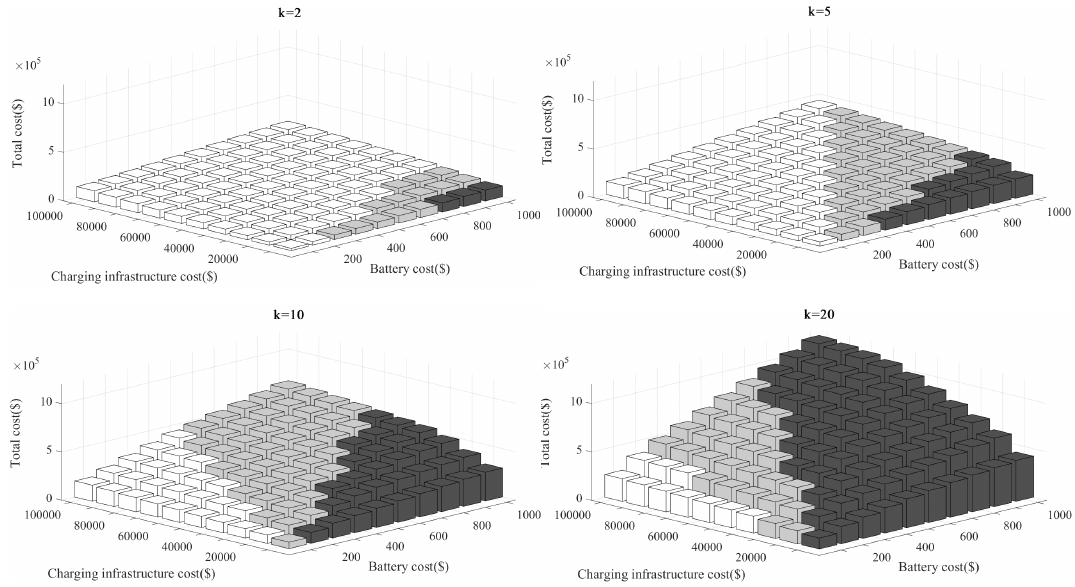
Figure 11. Cost comparison of EV types for the Gumi case (white region: SWC is competitive; gray region: QWC is competitive; black region: DWC is